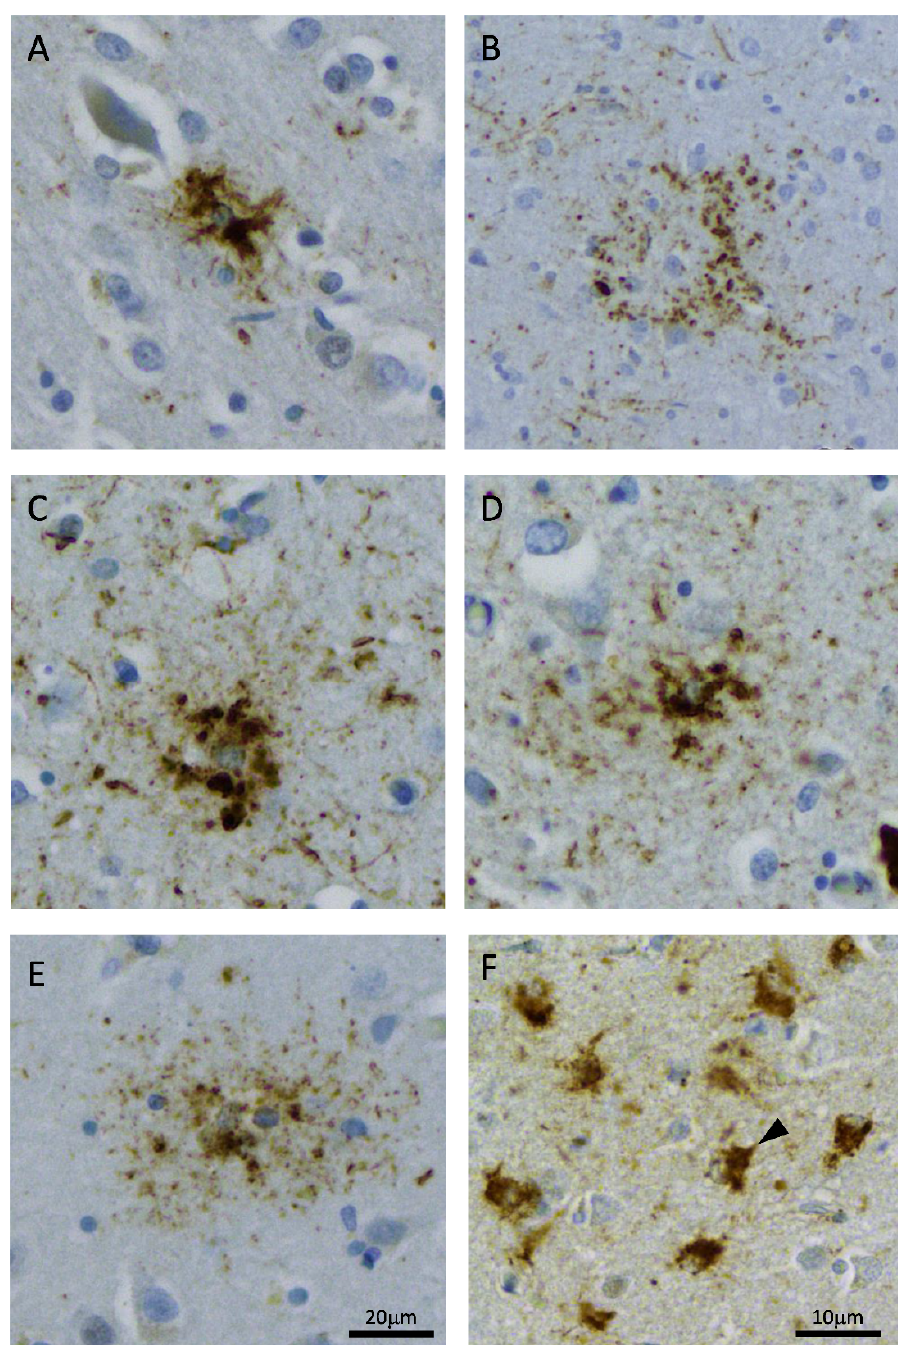
Figure 1. Astrocytic morphologies of frontotemporal lobar degeneration with tau (FTLD-tau) and aging-related tau astrogliopathy (ARTAG), immunostained with AT8-tau antibody. Dense tau fibrils in a tufted astrocyte in progressive supranuclear palsy (PSP, A ); annular punctate tau in an astrocytic plaque in corticobasal degeneration (CBD, B ); a globular astroglial inclusion in globular glial tauopathy (GGT, C ); short, thick tau processes in a ramified astrocyte in Pick’s disease (PiD, D ); ramified and bushy tau process in a granular/fuzzy astrocyte ( E ) and short dense tau deposits in thorny astroctyes (arrowhead) ( F ). Granular/fuzzy ( E ) and thorny ( F ) astrocytes are pathogno-monic of argyrophilic grain disease (AGD) and ARTAG. ( A – E ) images at 200× magnification and ( F ) at 400× magnification. FTLD-tau subtypes are further distinguished by the differing anatomical location of their astrocytic tau aggregates. In PSP and CBD, pathology concentrates in the cortex and basal ganglia [60,61], in AGD pathology is in limbic and temporal regions [62], in GGT the grey matter and in PiD pathology is concentrated in cortex and limbic regions [61].